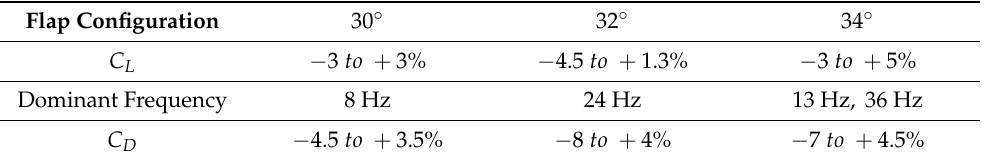
Table 1. Oscillations and dominant frequencies with flap